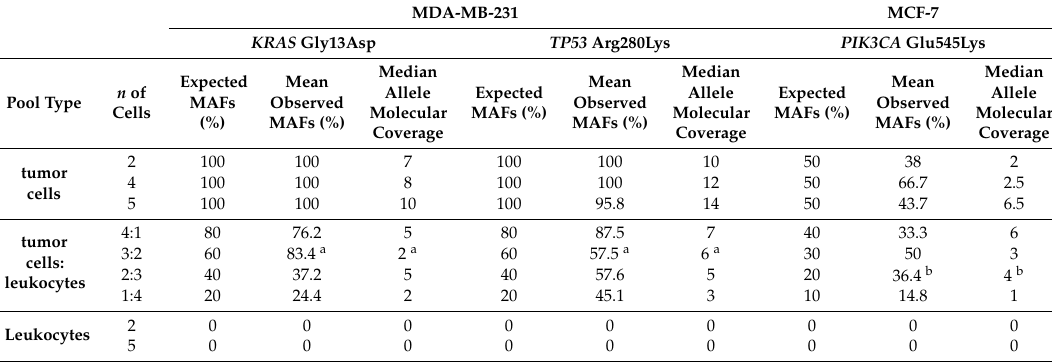
Table 2. Variant calling results from MDA, MCF-7, and leukocytes